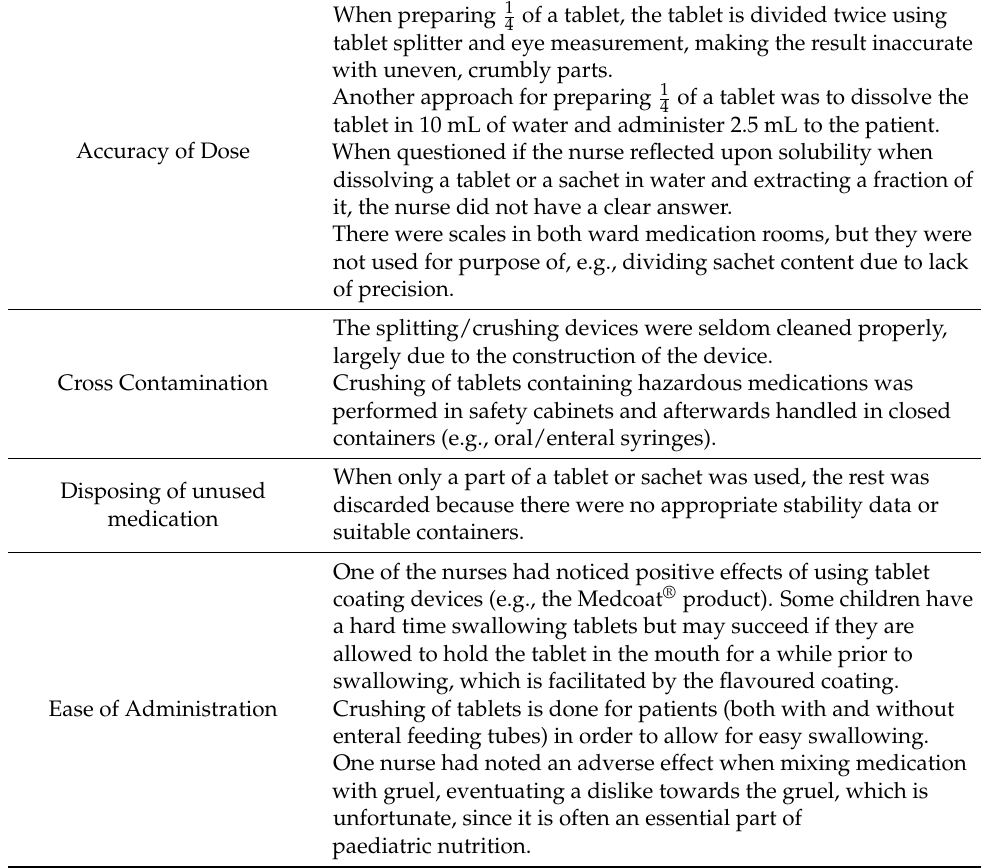
Table 3. Summary of findings from ward